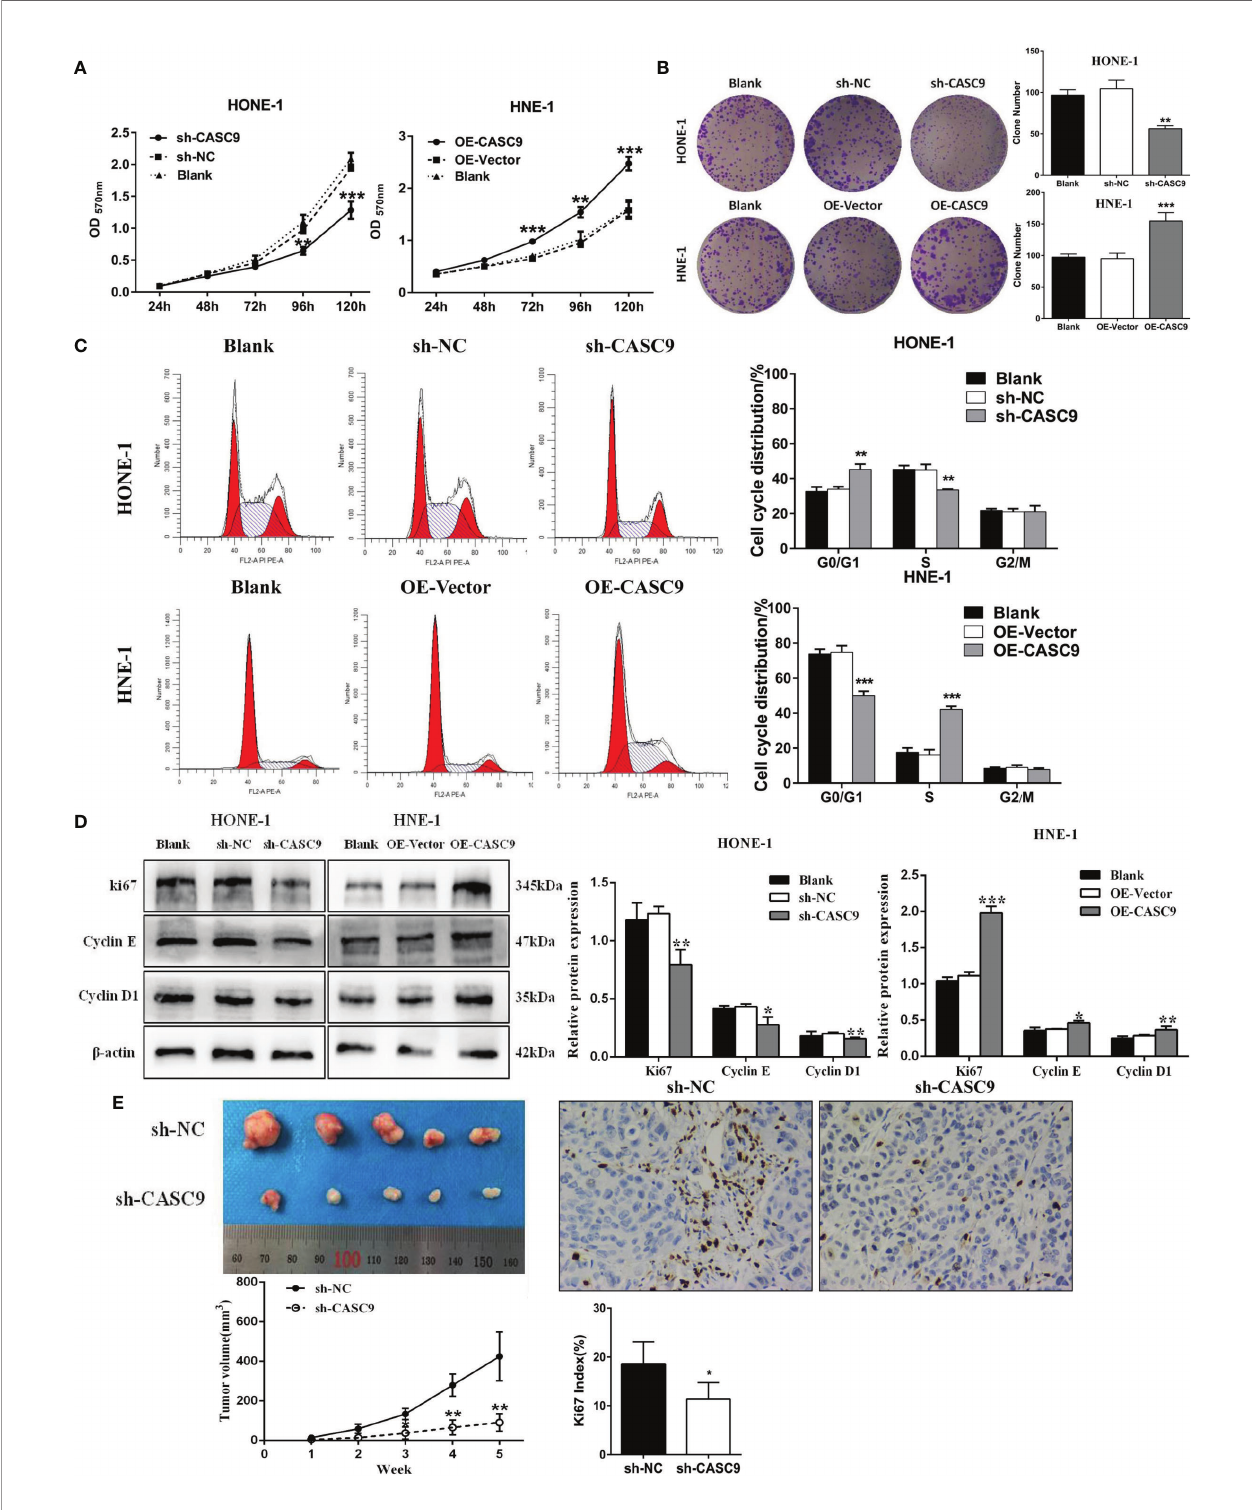
FIGURE 3 | CASC9 promoted NPC cell growth in vitro and in vivo . (A, B) The proliferation changes of NPCs were determined using MTT assay and colony-formation assay. (C) Cell cycle was analyzed by fl ow cytometry. (D) Protein levels of Cyclin D1, Cyclin E and Ki67 were measured by western blotting. (E) The knockdown of CASC9 inhibited NPC tumor growth in vivo . The expression of Ki67 was determined using immunohistochemistry. *P < 0.05, **P < 0.01, ***P <